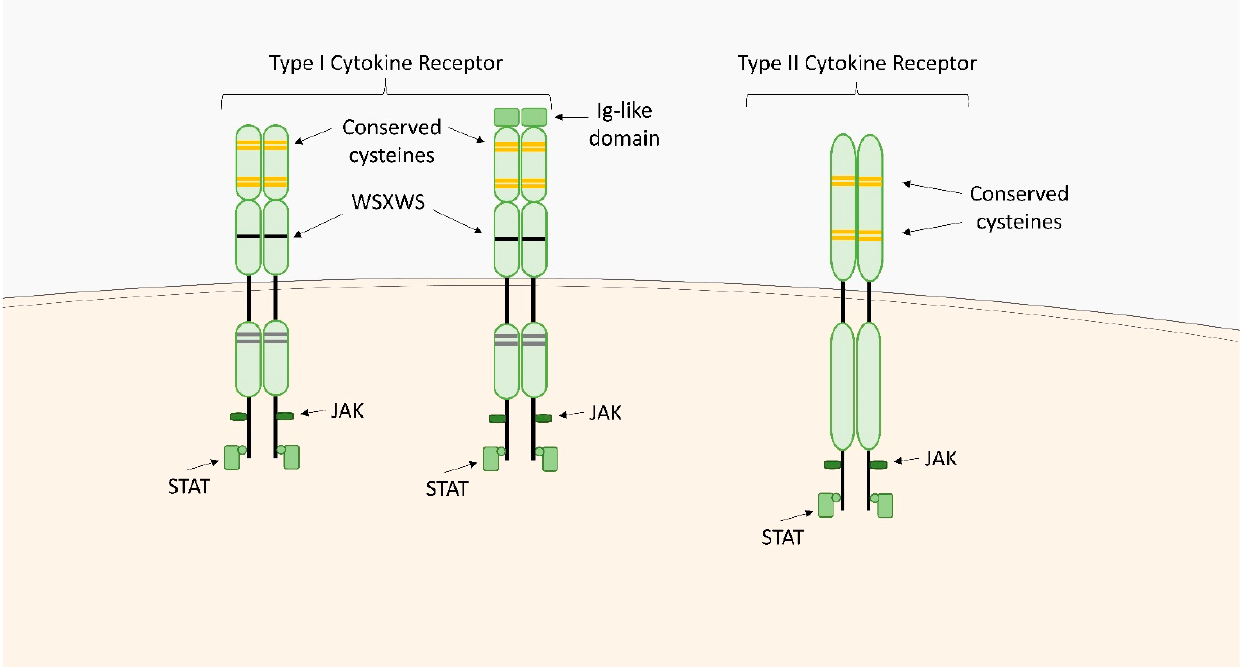
Figure 2. Structure of type I and type II cytokine receptors. The cytokine receptor homology region (CHR) contains four conserved cysteine moieties in the first FnIII domain and a tryptophan-serine-X-tryptophan-serine (WSXWS) motif in the second FnIII domain. Many type I cytokine receptors also contain immunoglobulin (Ig) domains. Cytoplasmic receptor domains contain sites for JAK and STAT binding. Type II cytokine receptors: CHRs have conserved cysteine residues arranged differently and do not contain the WSXWS motif compared to type I cytokine receptors. The cytoplasmic receptor domains contain sites for JAK and STAT binding.